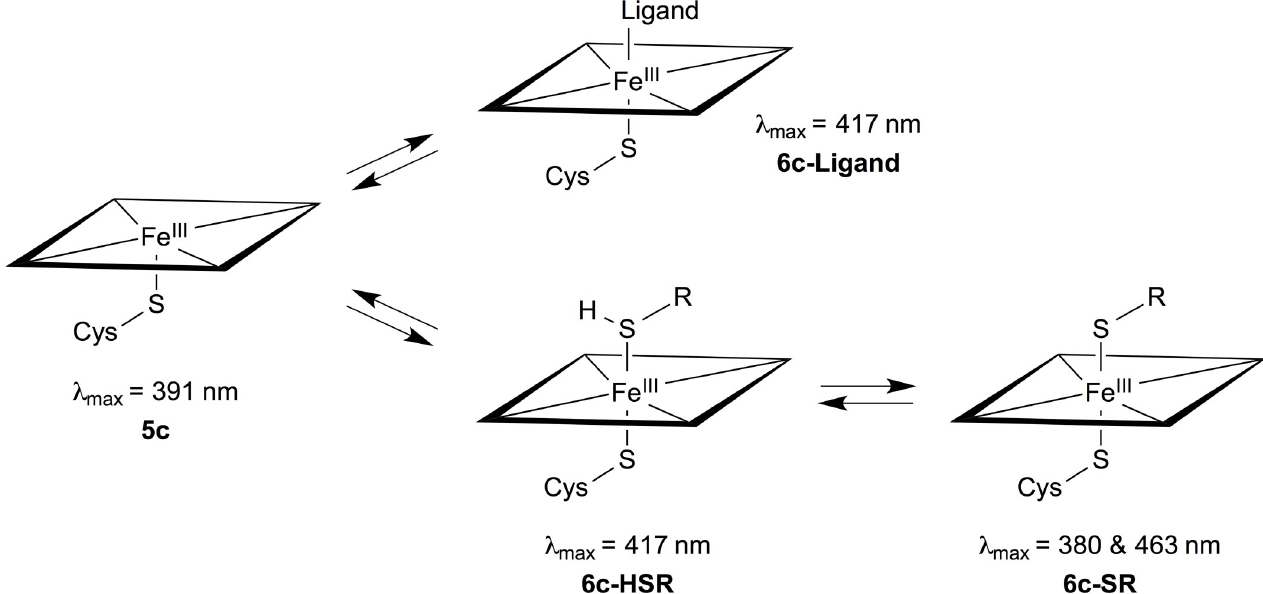
Fig 5. Thiol-heme binding. The equilibria between binding of thiols, thiolates and other ligands to heme proteins as suggested in reference [48]. 5c and 6c refer to the iron being five- and six-coordinated, respectively. Soret maxima are from reference [48] as well.